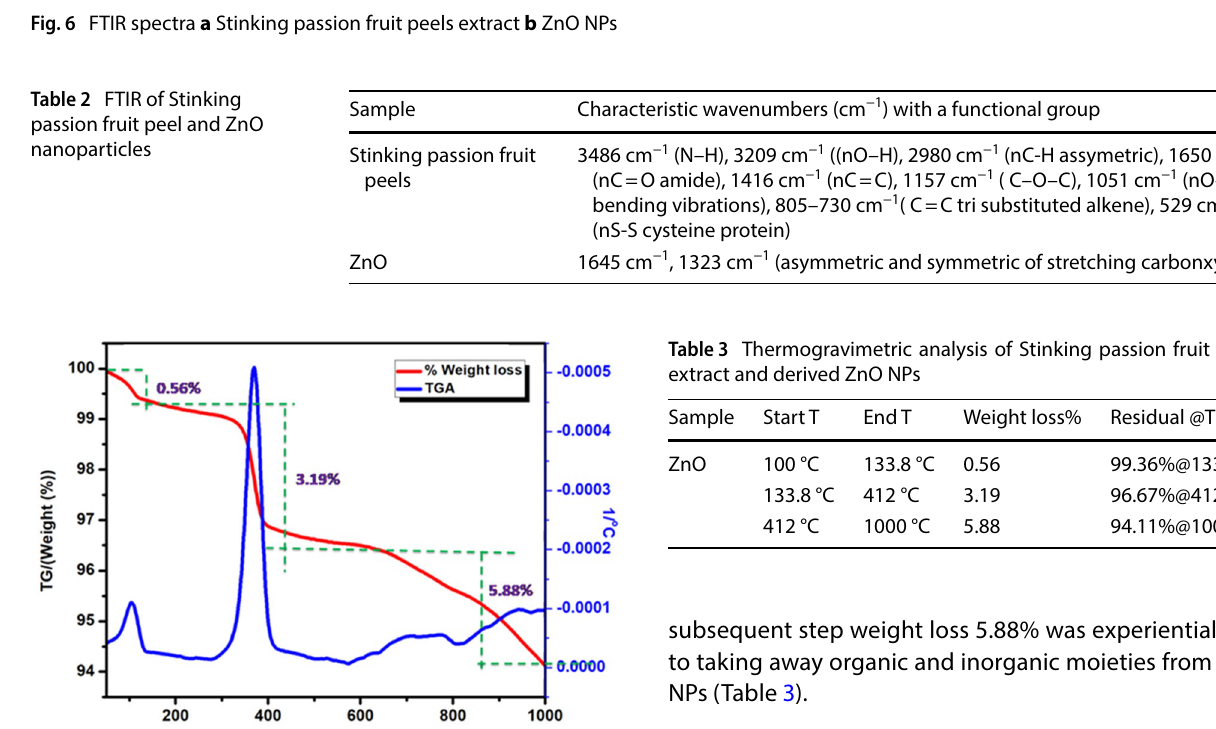
Fig. 6 FTIR spectra a Stinking passion fruit peels extract b ZnO NPs